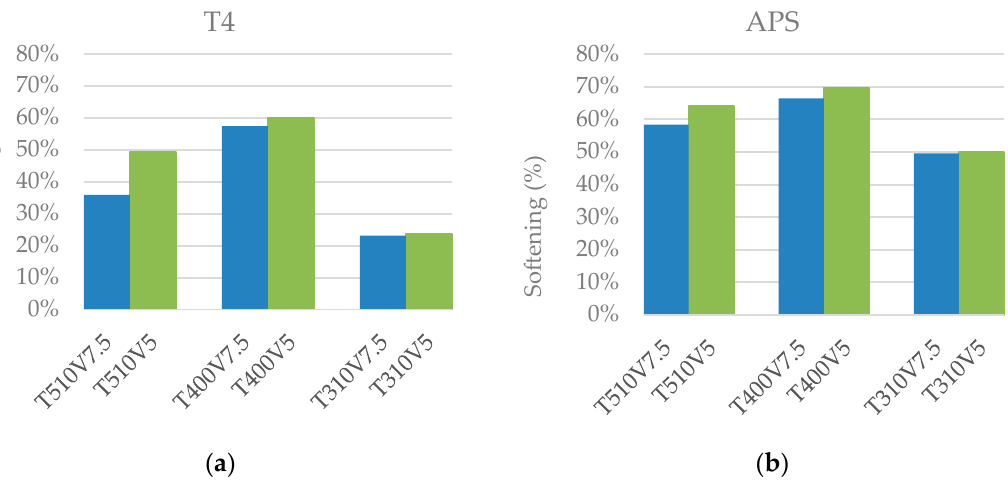
Figure 29. ( a ) Softening level reached in T4 state for all investigated laser treatments; ( b ) Softening level reached in APS state for all investigated laser treatments.